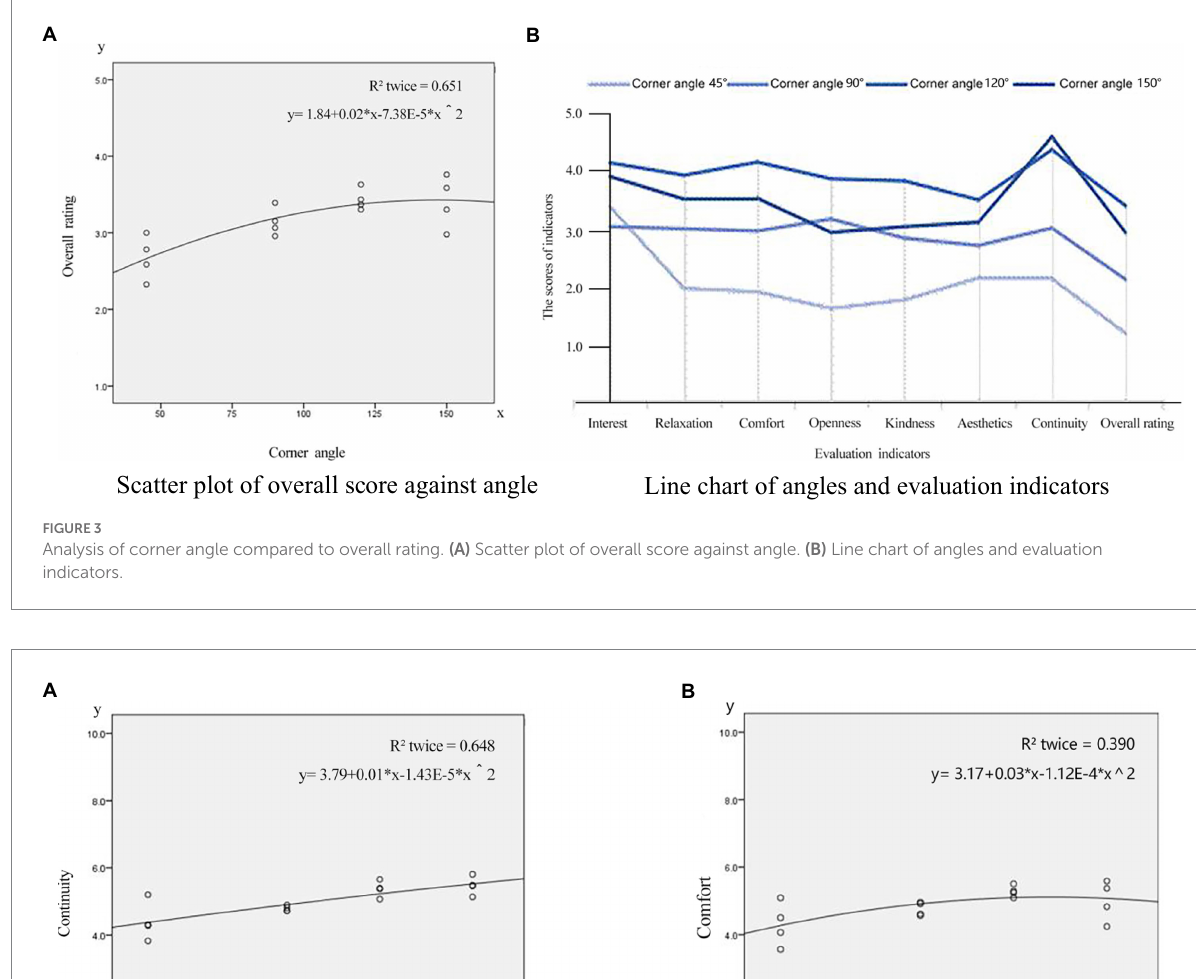
FIGURE 4 The scatter analysis of the spatial corner angle. (A) Scatter plot of continuity against corner angle. (B) Scatter plot of comfort against corner